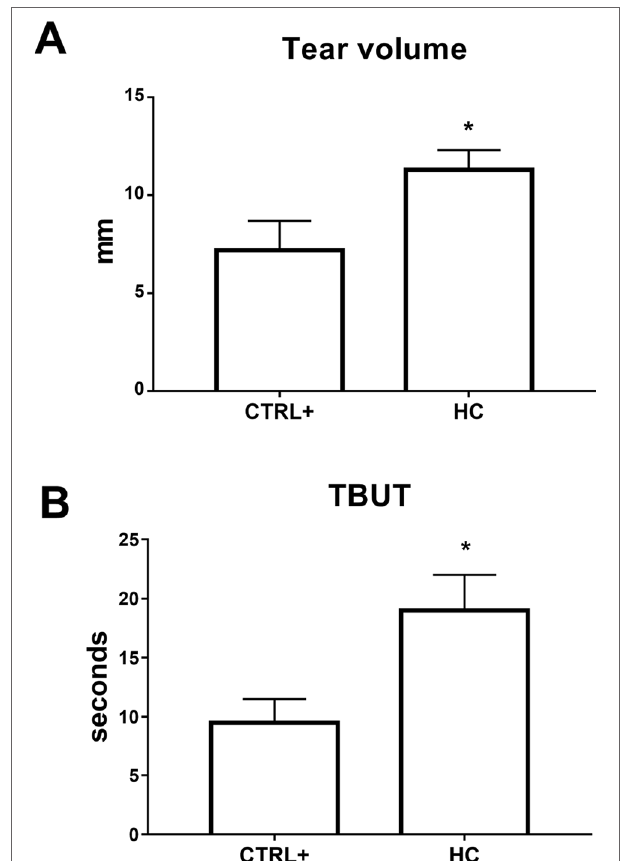
FIGURE 5 | Tear volume (A) and tear film stability (B) in atropine induced dry eye model. TBUT, tear breakup time. *p < 0.05 HC vs. CTRL+ (eye treated with atropine; no treatment with HC); HC, hydrocortisone; n = 6.